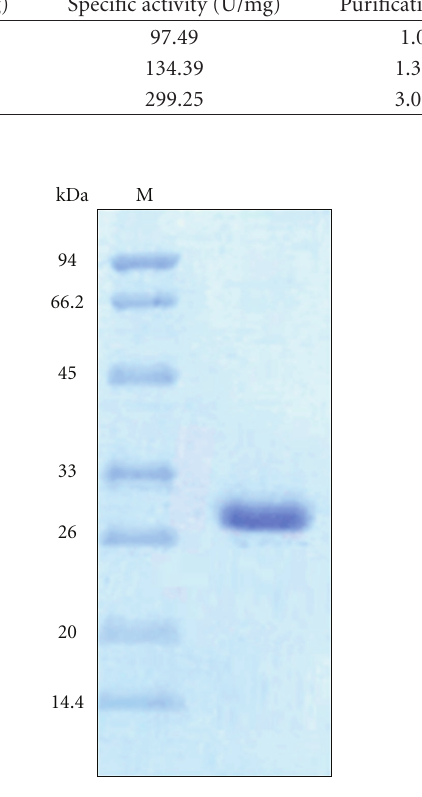
Figure 4: SDS-PAGE analysis of purified xylanases from Bacillus arseniciselenatis DSM 15340. Lane M: molecular markers; Lane B: Purified xylanase enzyme.